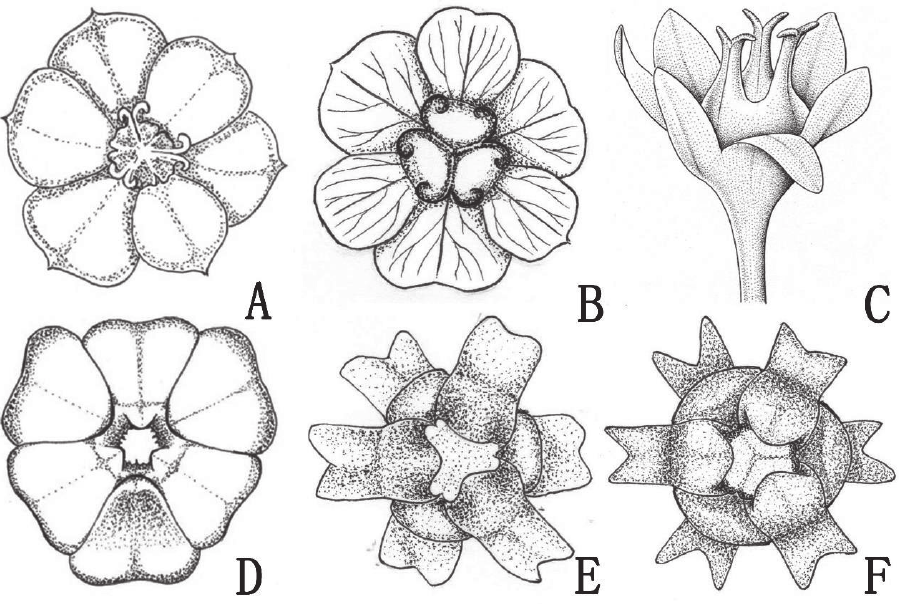
Figure 6. Breynia hiemalis ( A, D ), B. compressa ( B, E ), B. granulosa ( C ), B. delavayi ( F ). A–C pistillate flowers D–F staminate